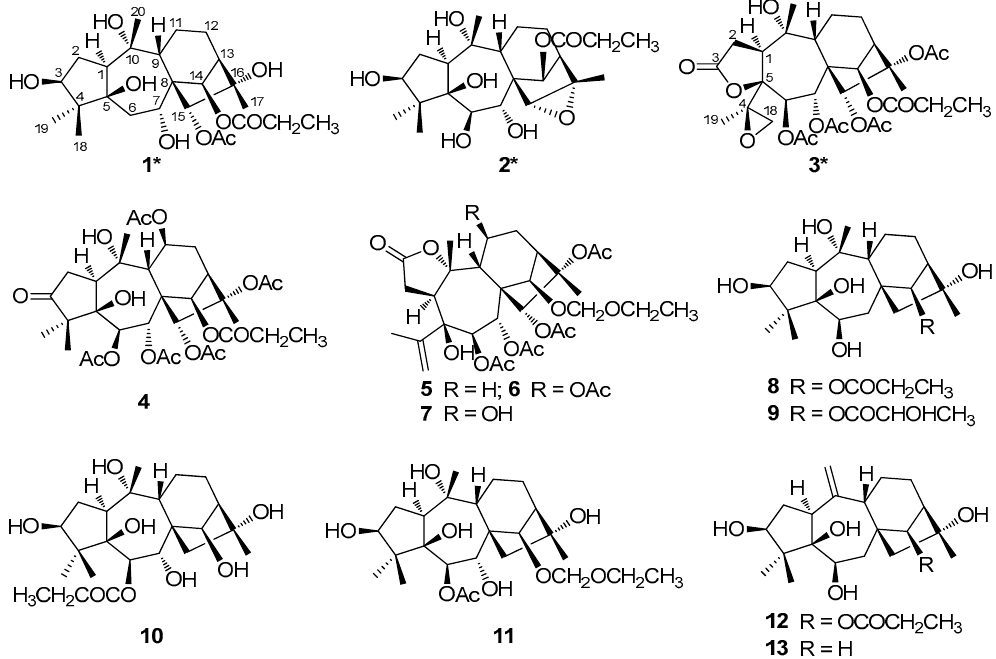
Figure 2. Structures of grayanane diterpenoids 1–13 isolated from P. formosa .